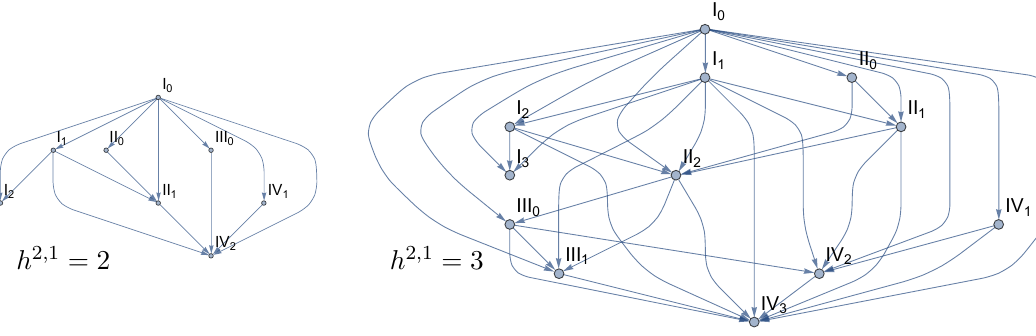
Figure 4 . Graphs of allowed type enhancements for (cid:12)eld spaces with h 2 ; 1 complex (cid:12)elds. In terms of Calabi-Yau geometries, h 2 ; 1 is the associated Hodge number. An arrow denotes that a starting type of locus may enhance over a sub-locus, corresponding to an intersection, to the end type. Note that the enhancement relations are not transitive. For example, in the h 2 ; 1 = 2 case, there is a chain of II 0 ! II 1 ! IV 2 enhancements, but there is no direct enhancement from II 0 to IV 2